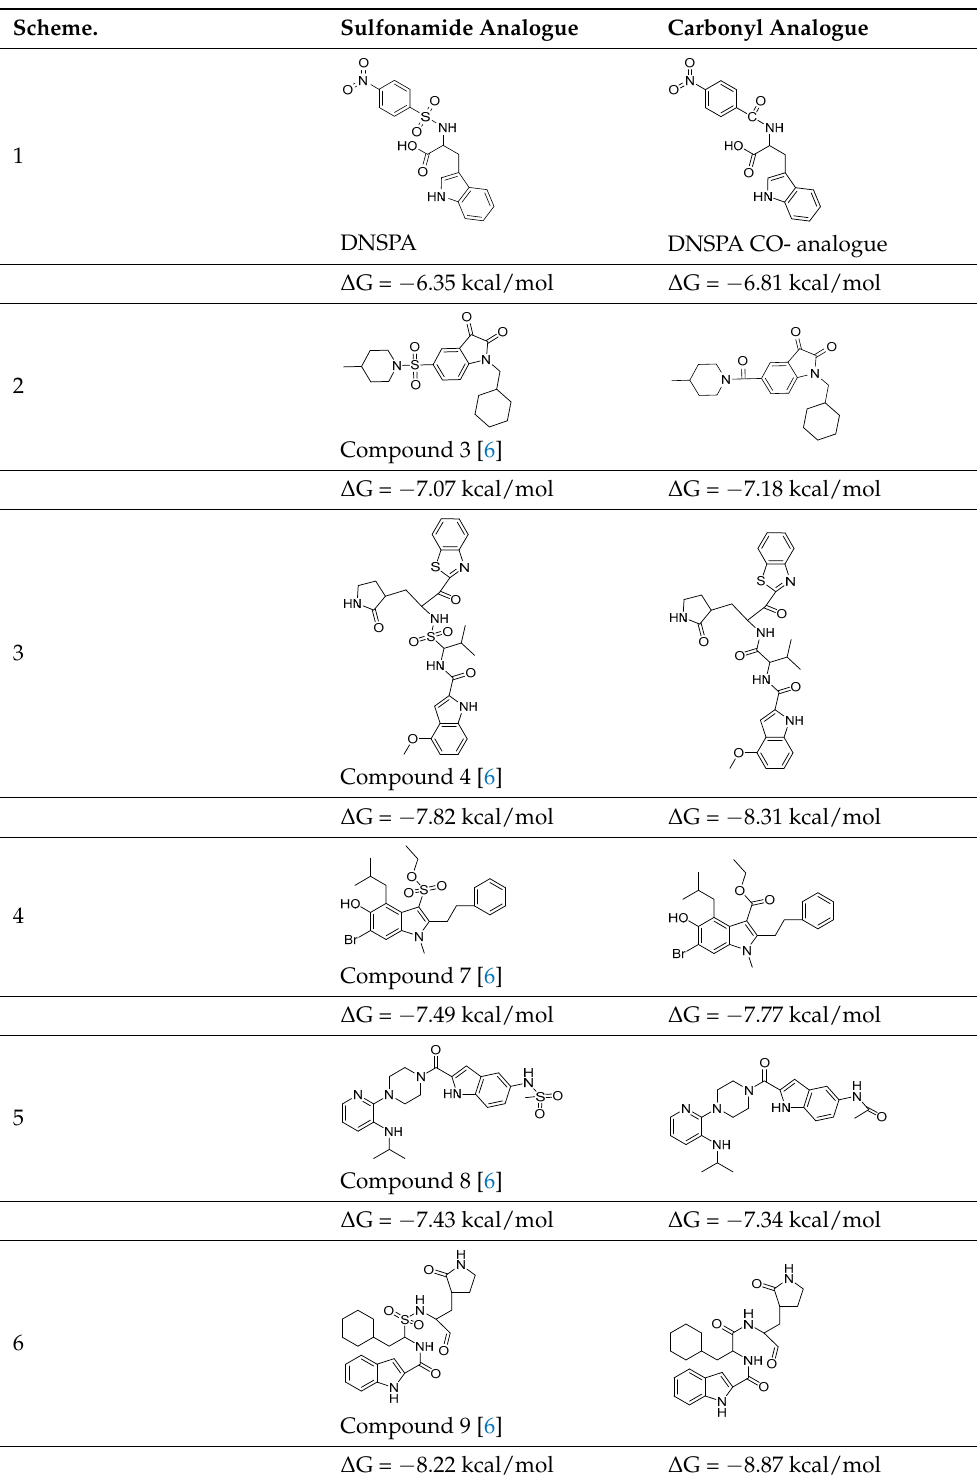
( b ) Figure 6. ( a ) 2D representation of the binding interactions between DNSPA and 5MMN. ( b ) 2D rep- resentation of the binding interactions between DNSPA and 6LU6 . The docking scores of some carbonyl and the sulfonamide analogues with indole moiety were studied and compared (Table 5). It was observed that the carbonyl analogues had a slightly higher binding affinity than their sulfonamide counterpart, though this in- crease is not significant. Table 5. Docking scores of sulfonamide and carbonyl analogues of indole derivatives. Scheme. Sulfonamide Analogue